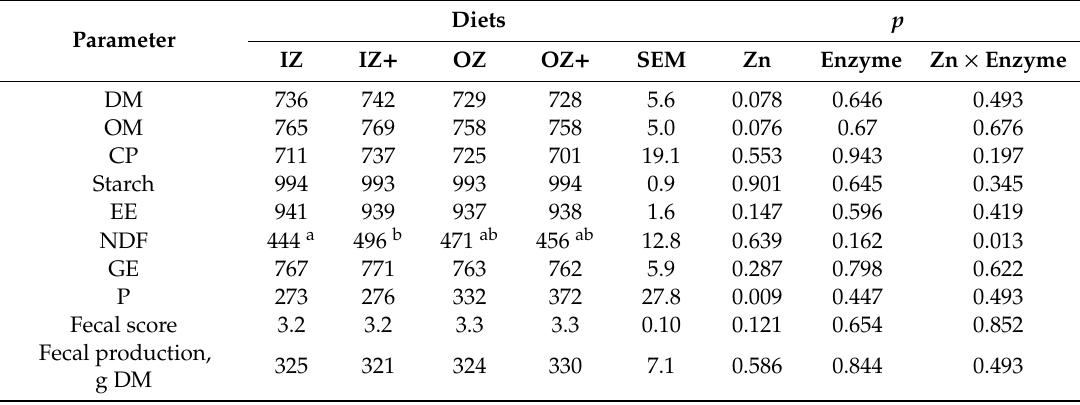
Table 5. Digestibility of macronutrients, P and gross energy (GE) expressed as g / kg, fecal score and production of dogs fed the experimental diets. a,b Values in the same row that share a common superscript are not statistically di ff erent ( p > 0.05).